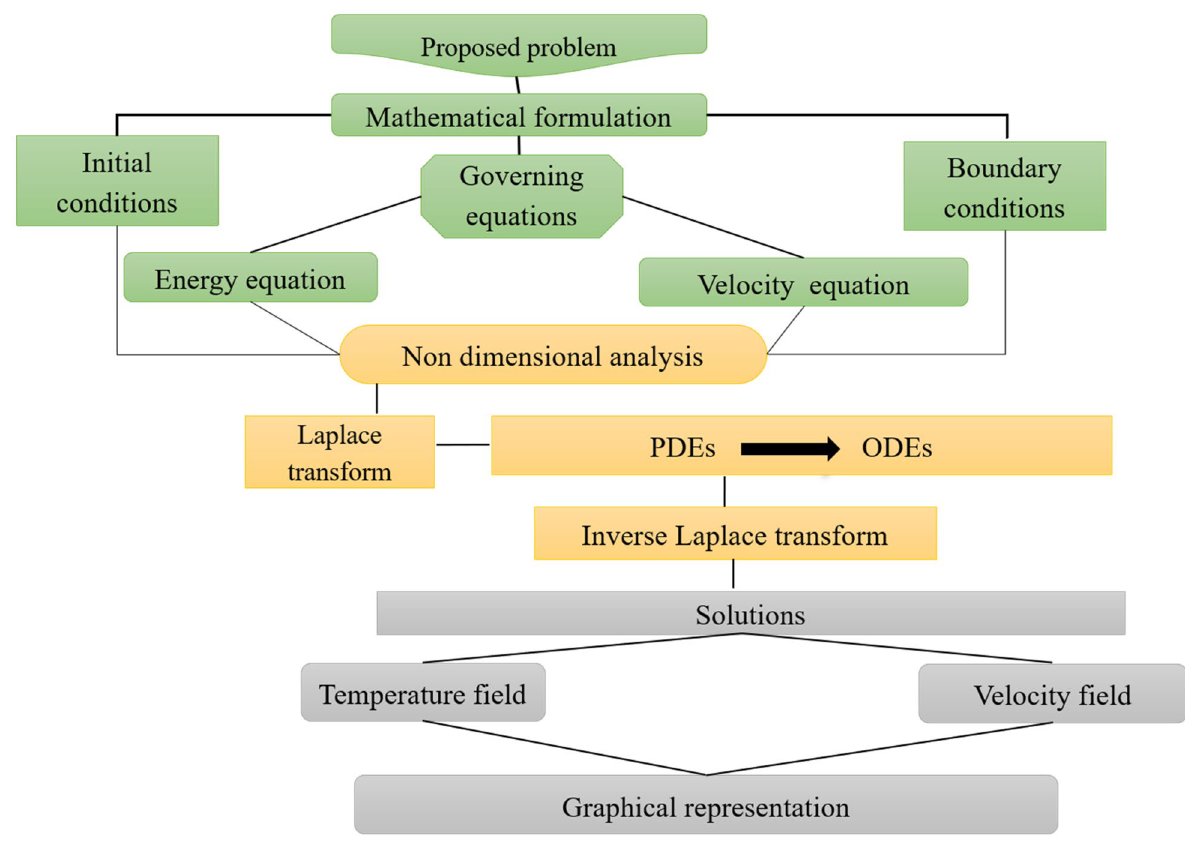
Figure 3. Flow chart of the steps-wise